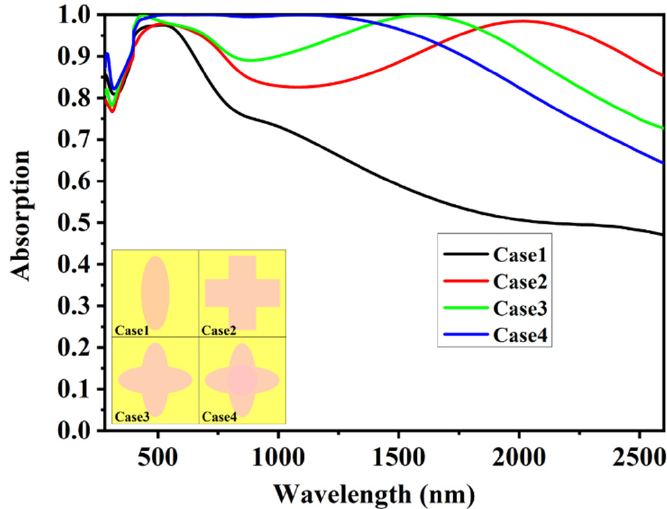
Figure 6. Absorption spectra of four different geometric structures.